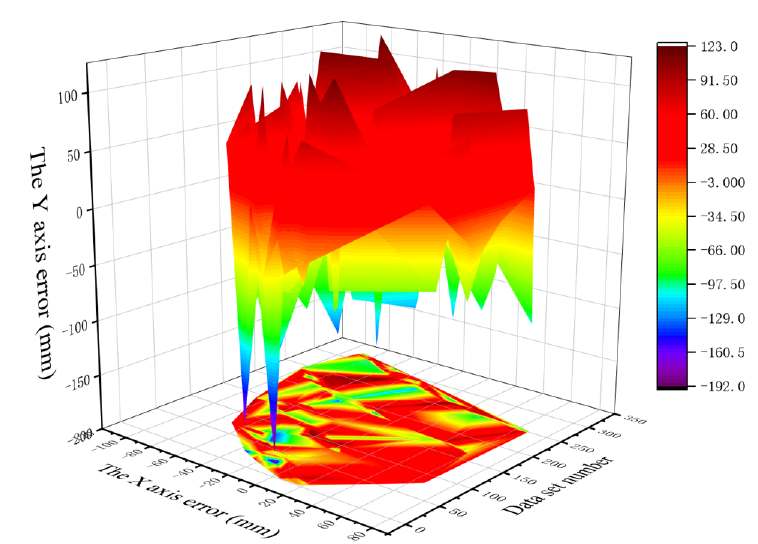
Figure 12. 2D ( X , Y ) accuracy of normal data sets based on C-T-CNN-SVM algorithm.